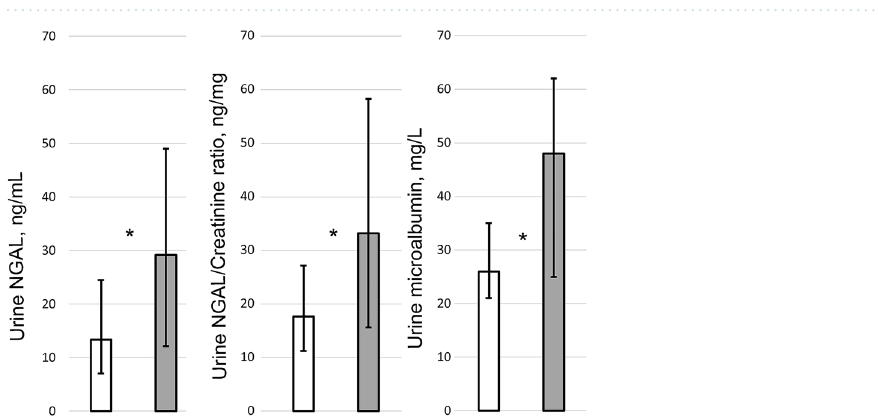
Figure 4. Bar graph showing the mean echocardiography ( A ) and Doppler measurements ( B ) in intrauterine growth restriction (IUGR) (grey) and control (white) newborns at the different time points. Echocardiography and Doppler assessments were not performed in eight infants in the control and three infants in the IUGR group at 72 h. Error bars represent standard deviation. *Statistically significant (P < 0.05). SVC superior vena cava, LVCO left ventricular cardiac output, RVCO right ventricular cardiac output, ACA anterior cerebral artery.